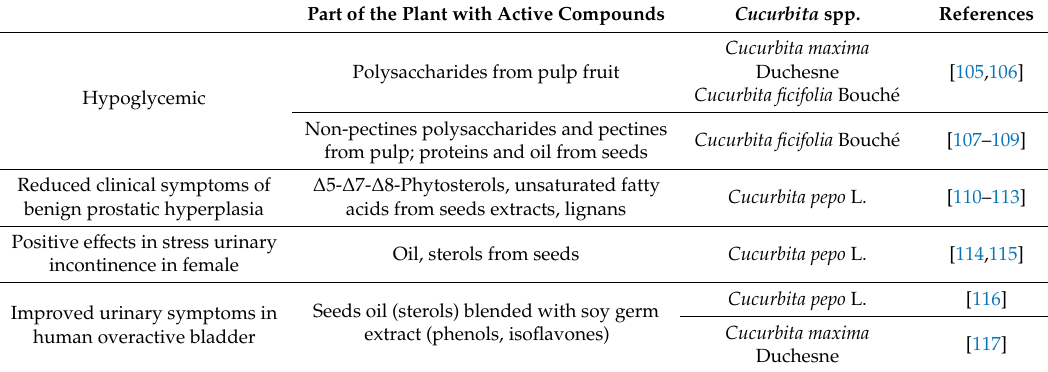
Table 6. Pharmacotherapeutic e ff ects of Cucurbita plants in human clinical studies. Part of the Plant with Active